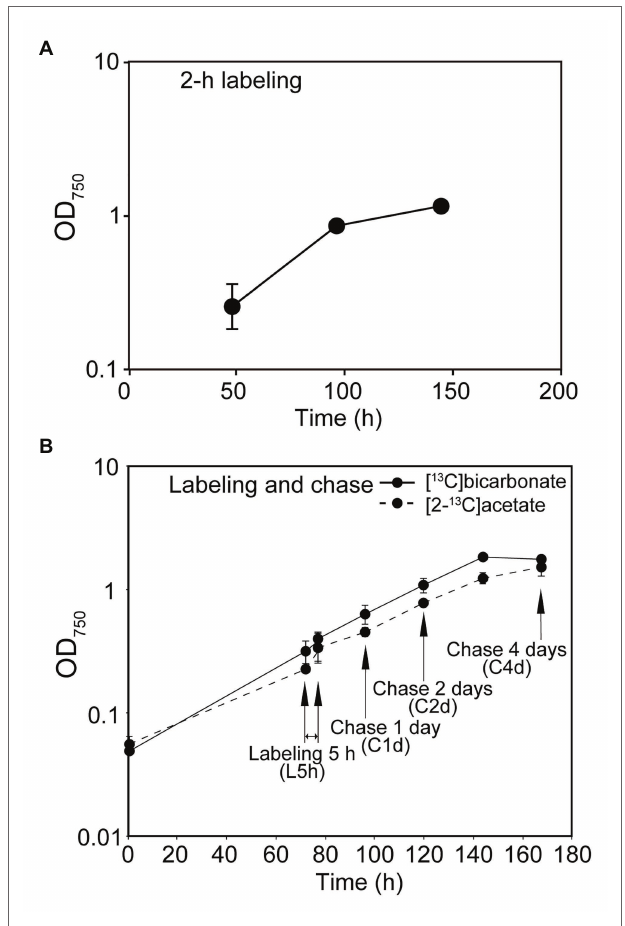
FIGURE 1 | Growth of cells used in the experiments. Turbidity at 750 nm is shown at each sampling point. (A) Labeling for 2 h. (B) Labeling for 5 h and